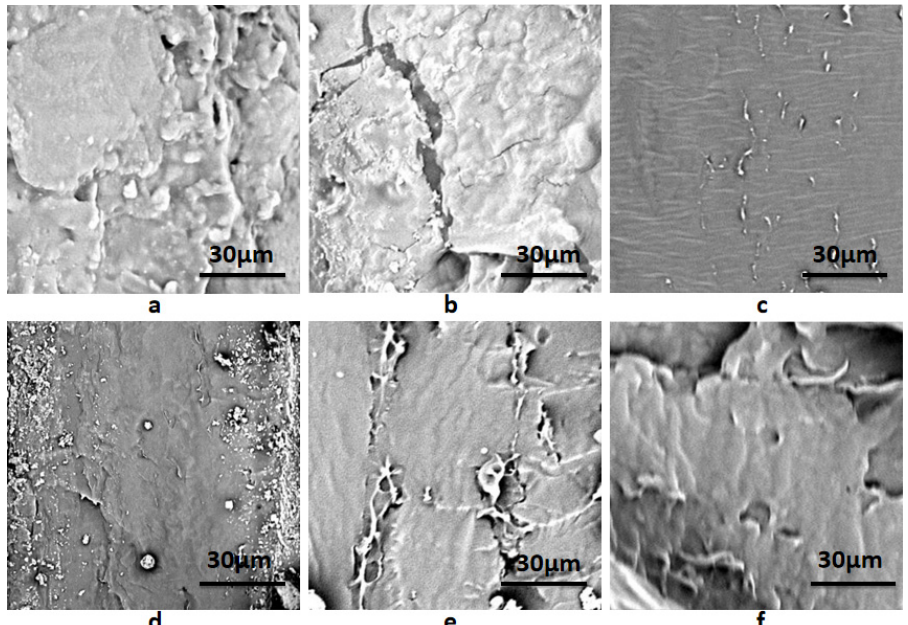
Figure 4. SEM images of composite membrane samples of ( a ) starch–PVA; ( b ) HNTs/starch–PVA; ( c ) CNF/starch–PVA; ( d ) HNTs–CNF/starch–PVA; ( e ) HNTs–KH560–CNF starch–PVA; ( f ) HNTs– KH570–CNF starch–PVA.